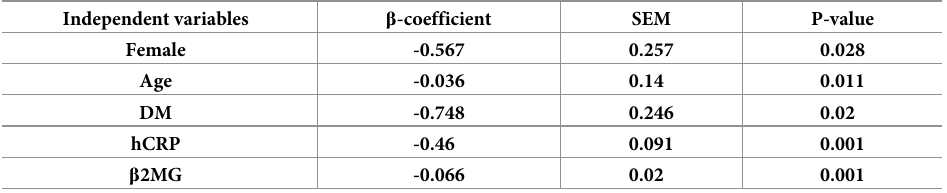
Table 1. Predictors for higher TSAT ( � 20%) levels in MHD patients (stepwise multiple linear regression